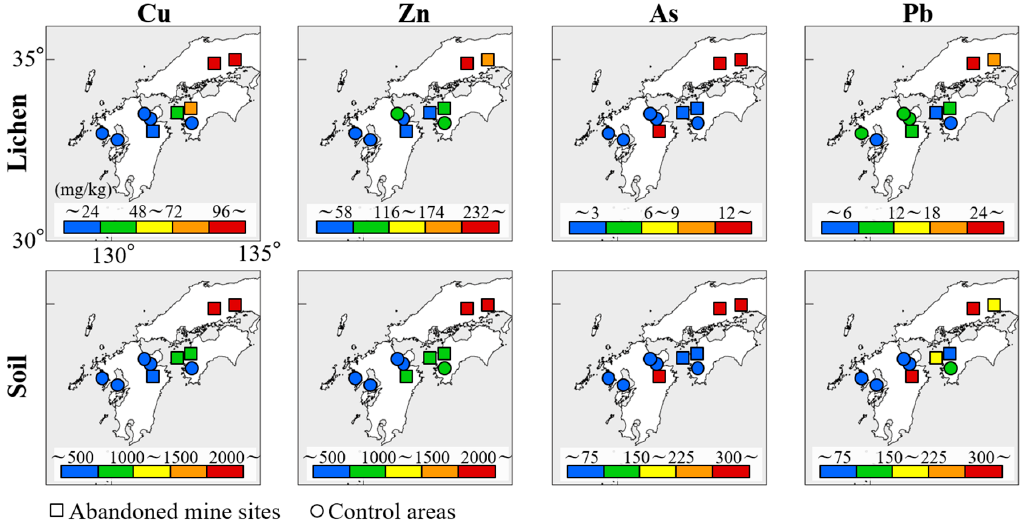
Figure 8. Distribution maps of the average concentrations of Cu, Zn, As, and Pb in lichens and soils at each sampling region in southwest Japan. The yellow dots indicate the environmental standards in Japan.